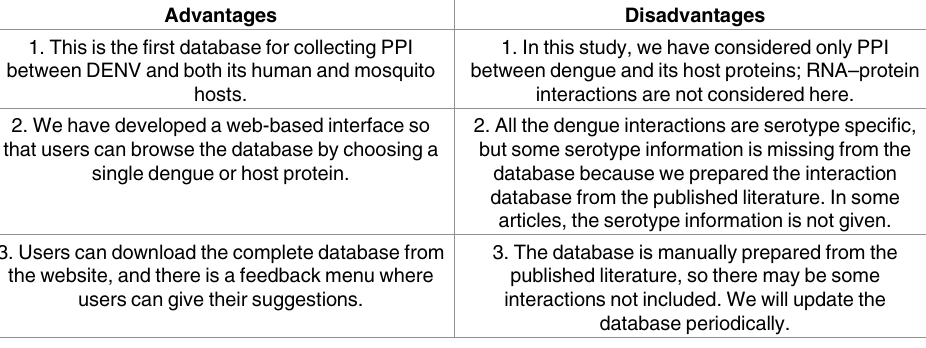
Table 2. Advantages and disadvantages of this